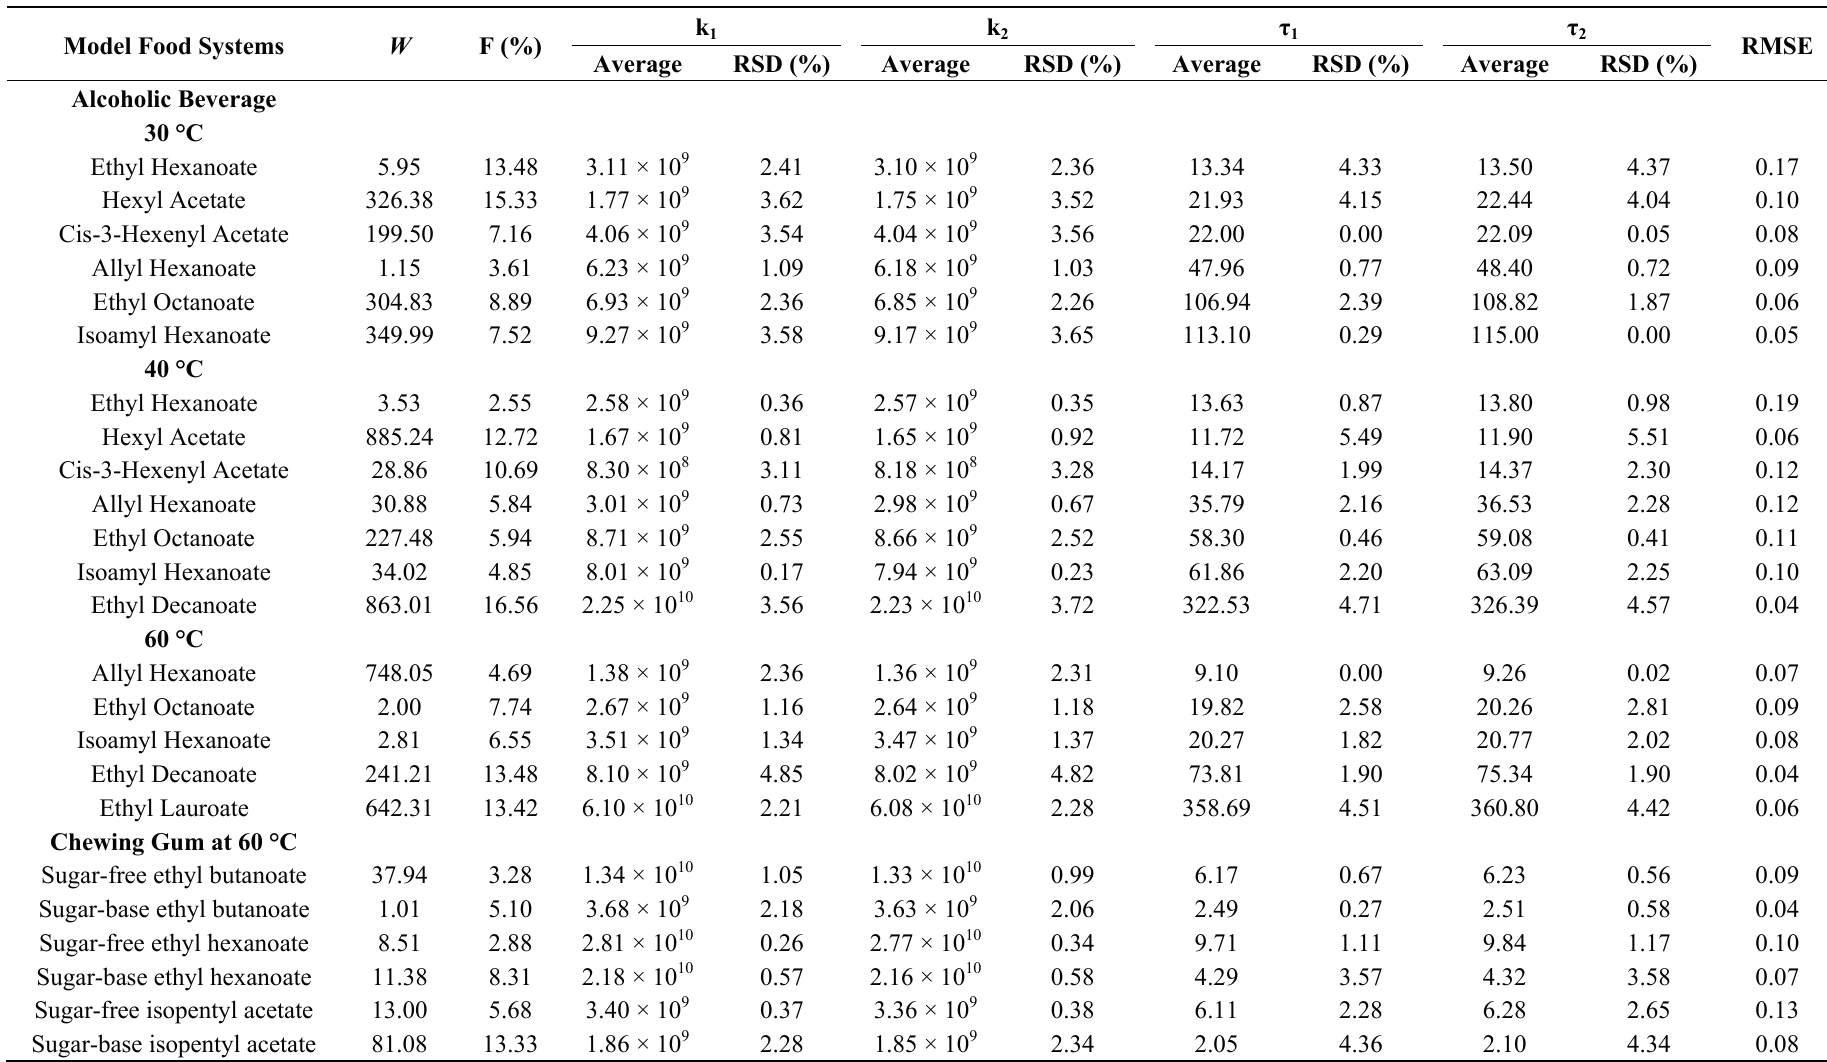
Table 1. Summary of weighting factor, RSD of parameters and RMSE of triplicates for flavor compounds in alcoholic beverage and chewing gum. Model Food